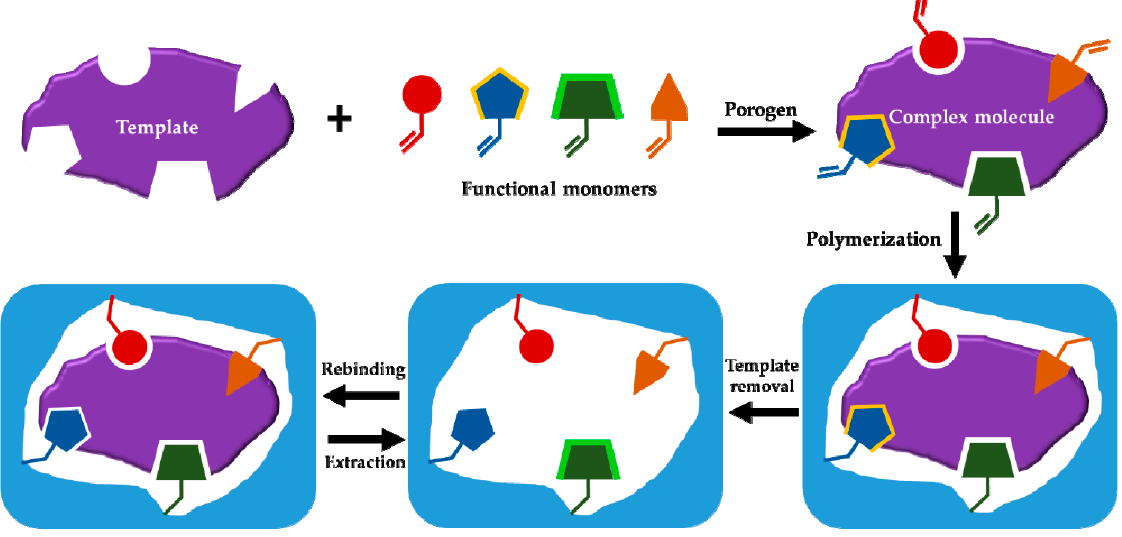
Figure 1. Schematic representation of MIP preparation .